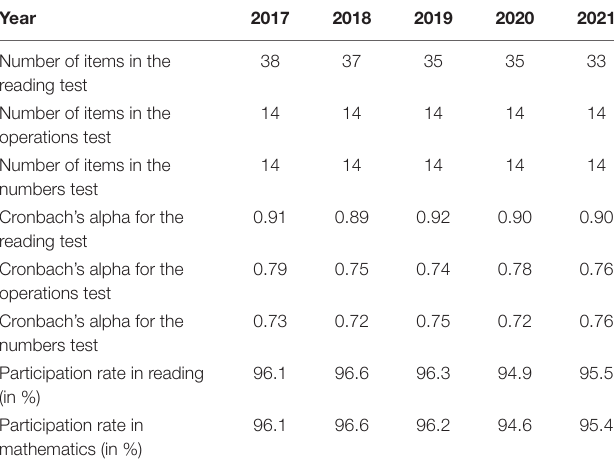
TABLE 2 | Psychometric properties of the competence assessments and participation